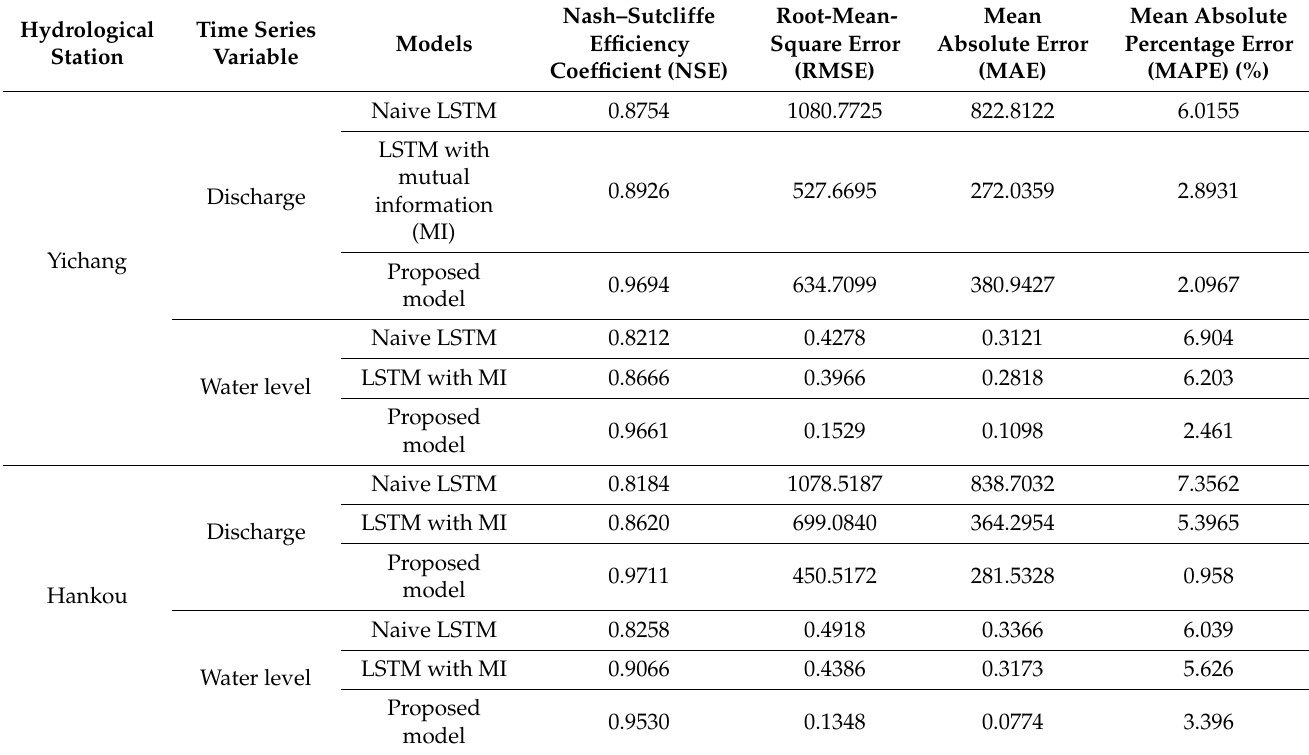
Table 2. The results of different forecasting methods for the Yichang and Hankou Hydrological Stations.